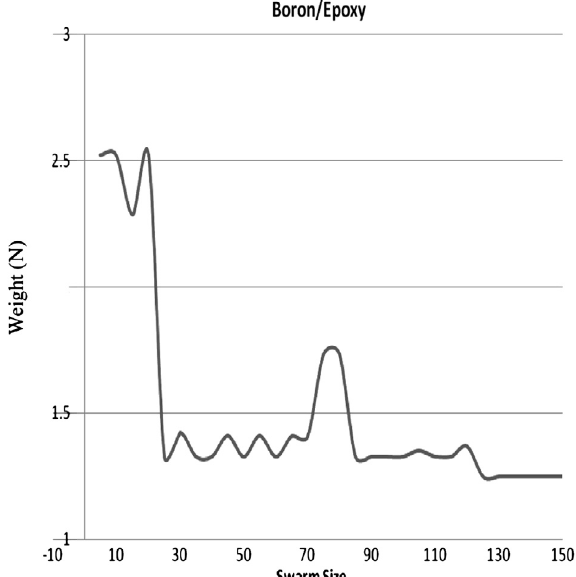
Figure 9. Variations of weight of Boron/Epoxy drive shafts with swarm size.